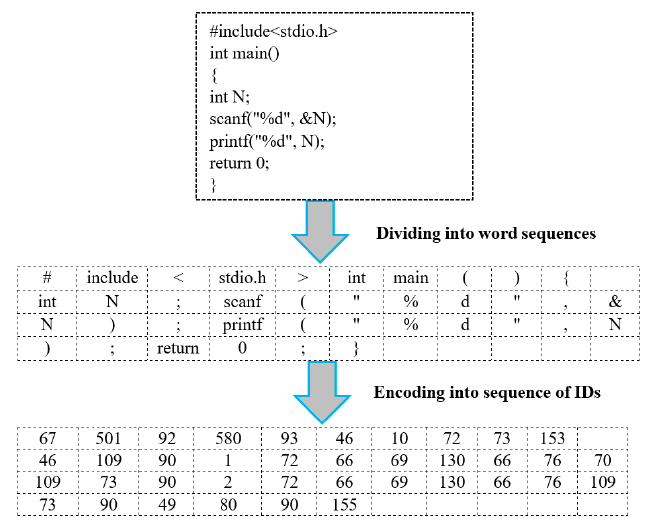
Figure 4. Word embedding and encoding process for source code. Table 1. Partial list of defined IDs for keywords, characters, and numbers.